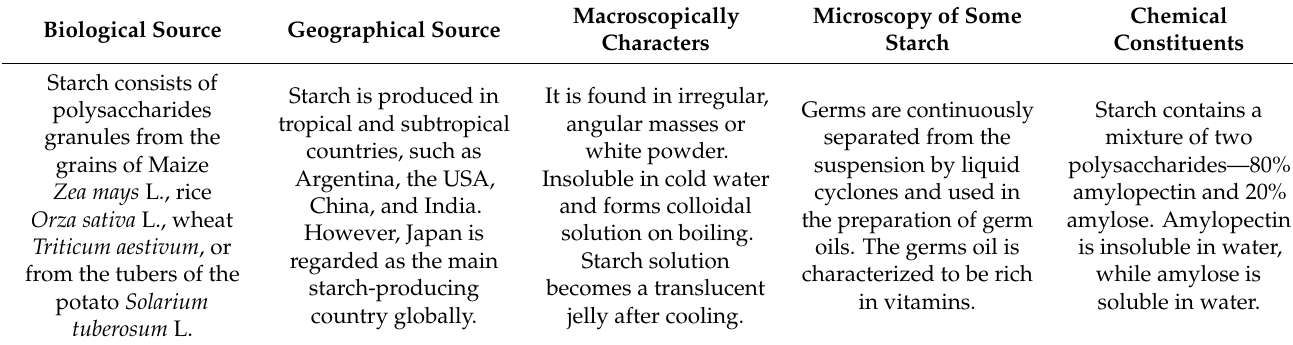
Table 2. Various sources of starch and their properties [9].